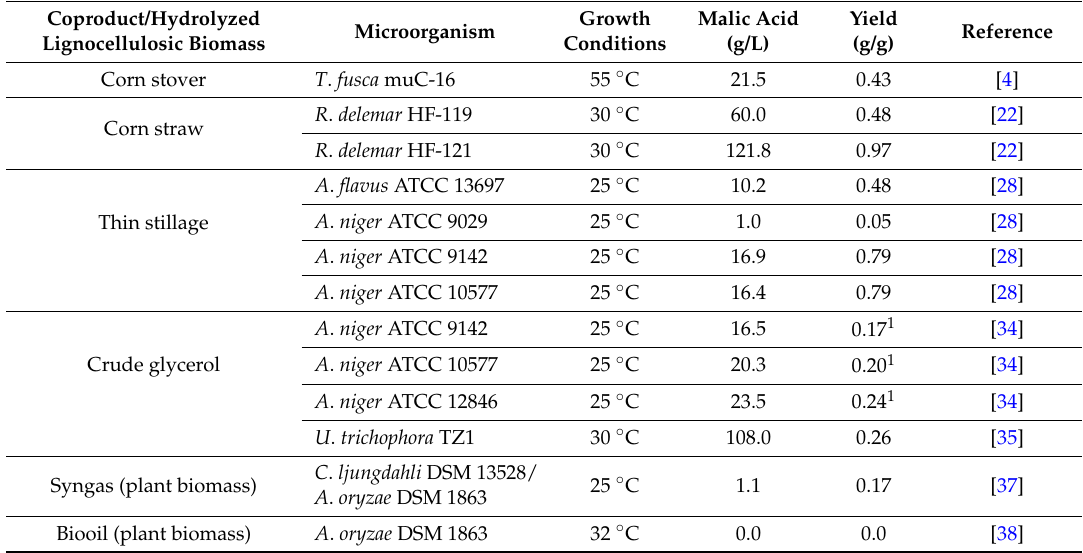
Table 1. Malic acid production by microorganisms grown on biofuel-processing coproducts or hydrolyzed lignocellulosic